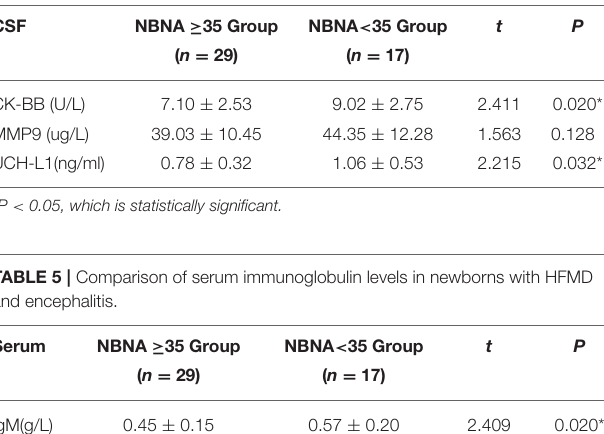
TABLE 4 | Comparison of cytokine levels in CSF of newborns with HFMD complicated with encephalitis.